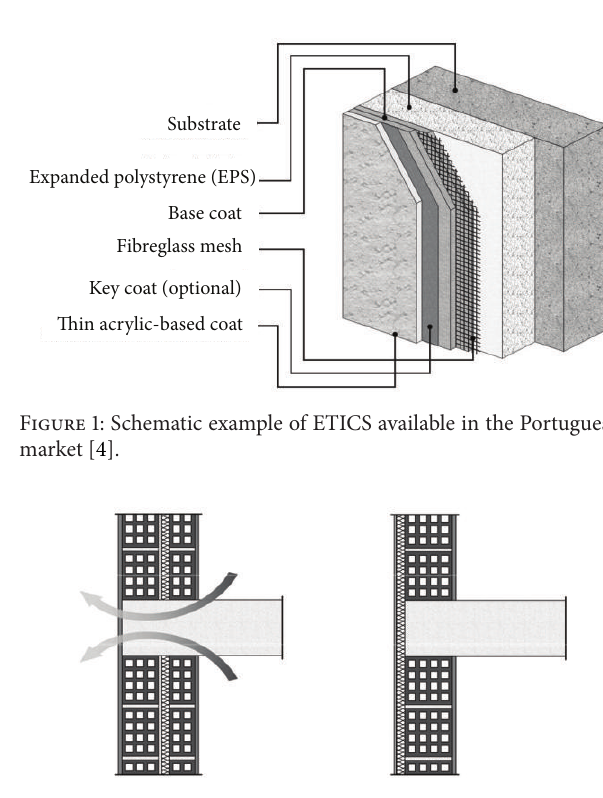
Figure 2: Reduction of heat losses due to the continued thermal insulation [4].